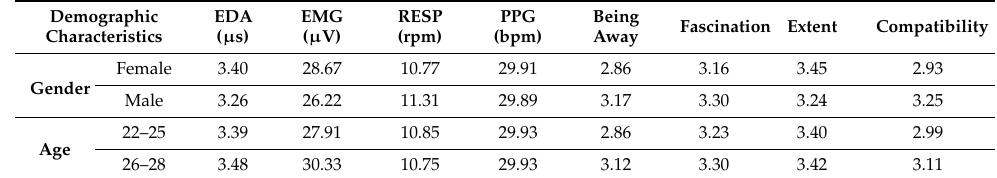
Table 6. Stress recovery and attention restoration potential of different demographic characteristics.